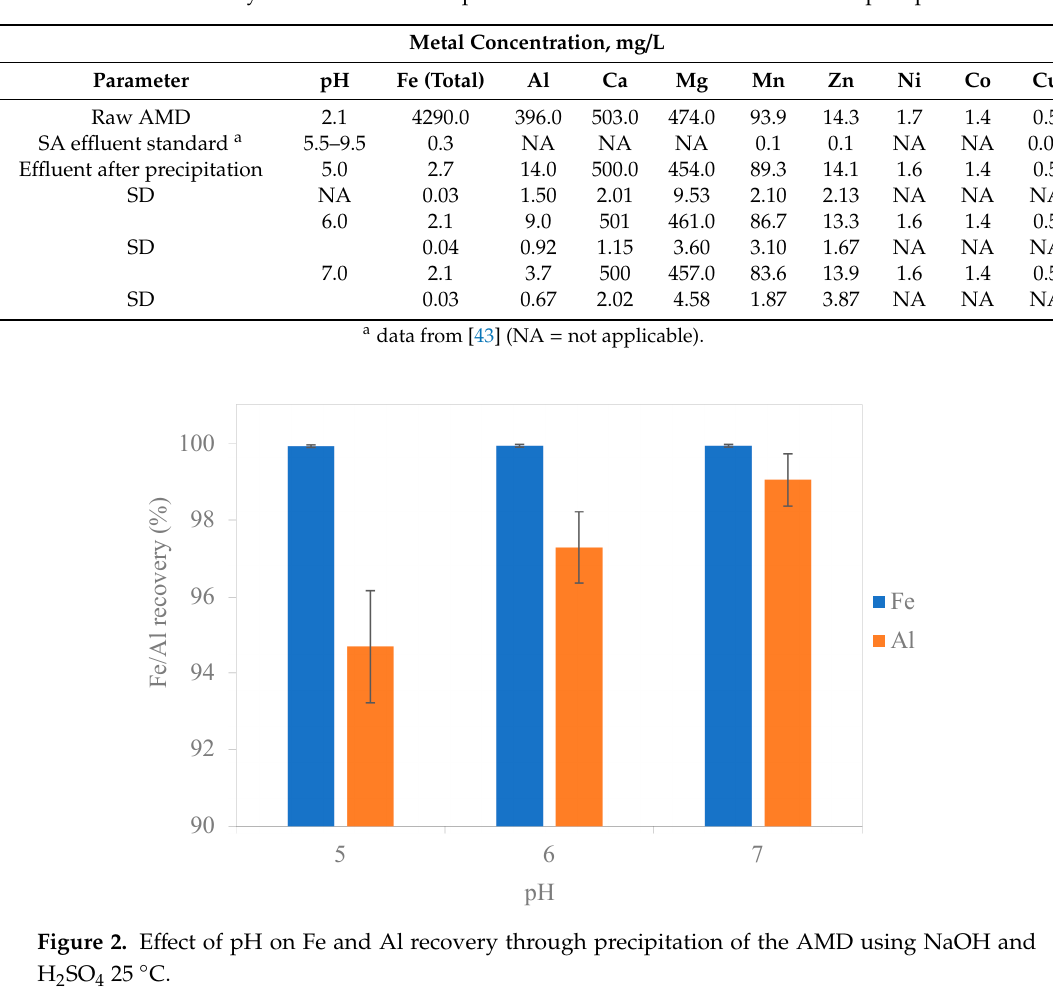
Table 2. Summary of the chemical composition of raw AMD and e ffl uents after precipitation.